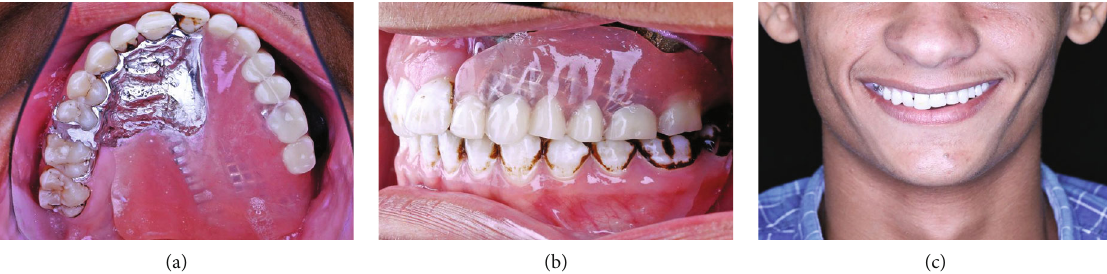
Figure 4: After prosthesis insertion: (a) intraoral occlusal view, (b) intraoral left side view, and (c) extraoral frontal view.